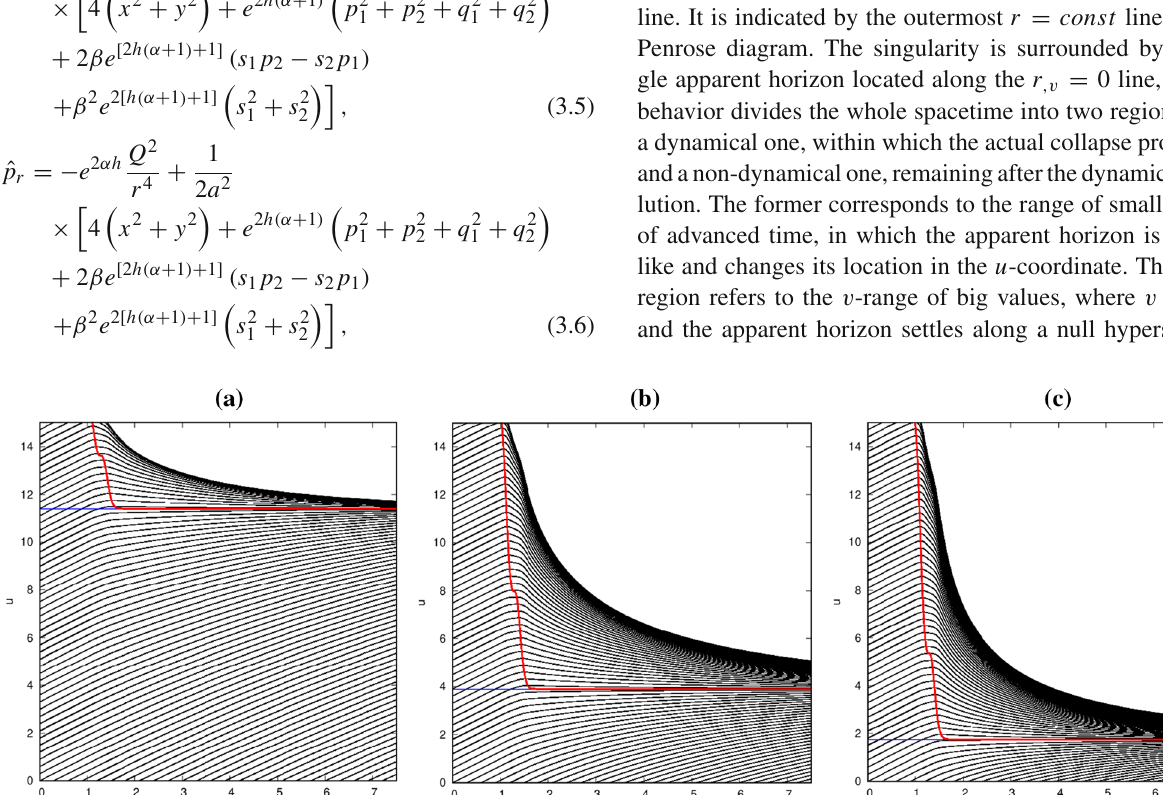
Fig. 2 Penrose diagrams of spacetimes emerging from evolutions with α = a 0 . 02, b 0 . 04 and c 0 .